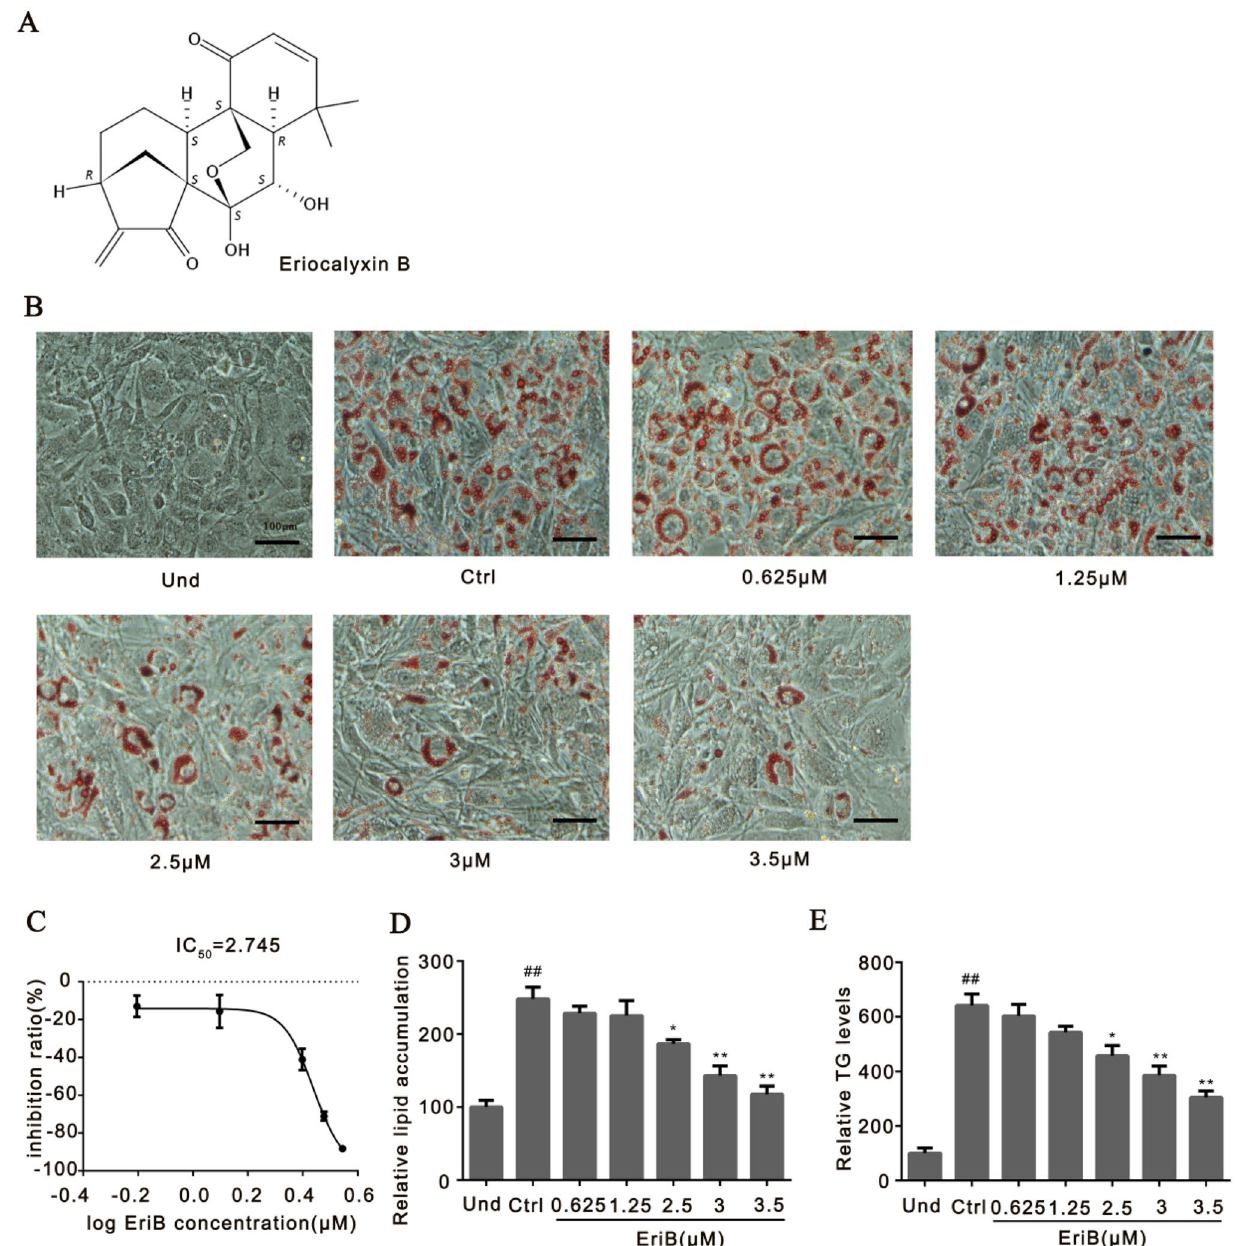
Fig. 1 Eriocalyxin B inhibited adipogenesis. a Chemical structure of eriocalyxin B. 3T3-L1 preadipocytes were incubated with indicated concentrations of eriocalyxin B for 7 days. b Representative images of 3T3-L1 cells treated with the inducing cocktail and a series of con- centrations of eriocalyxin B and stained with Oil red O. Scale bar, 100 μm. c Percentage of inhibition of the eriocalyxin B on